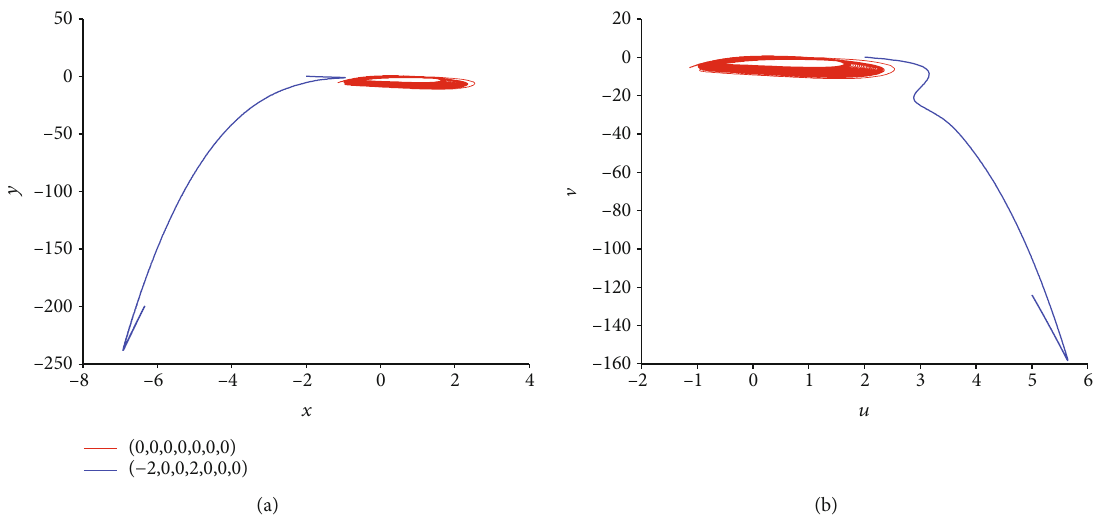
Figure 12: Coexistence of multiple fi ring patterns dependent on initial values in model (2) with k = 0 : 1 and I for initial value ð 0, 0, 0, 0, 0, 0, 0 Þ while the blue one is for ð − 2, 0, 0, 2, 0, 0, 0 Þ .